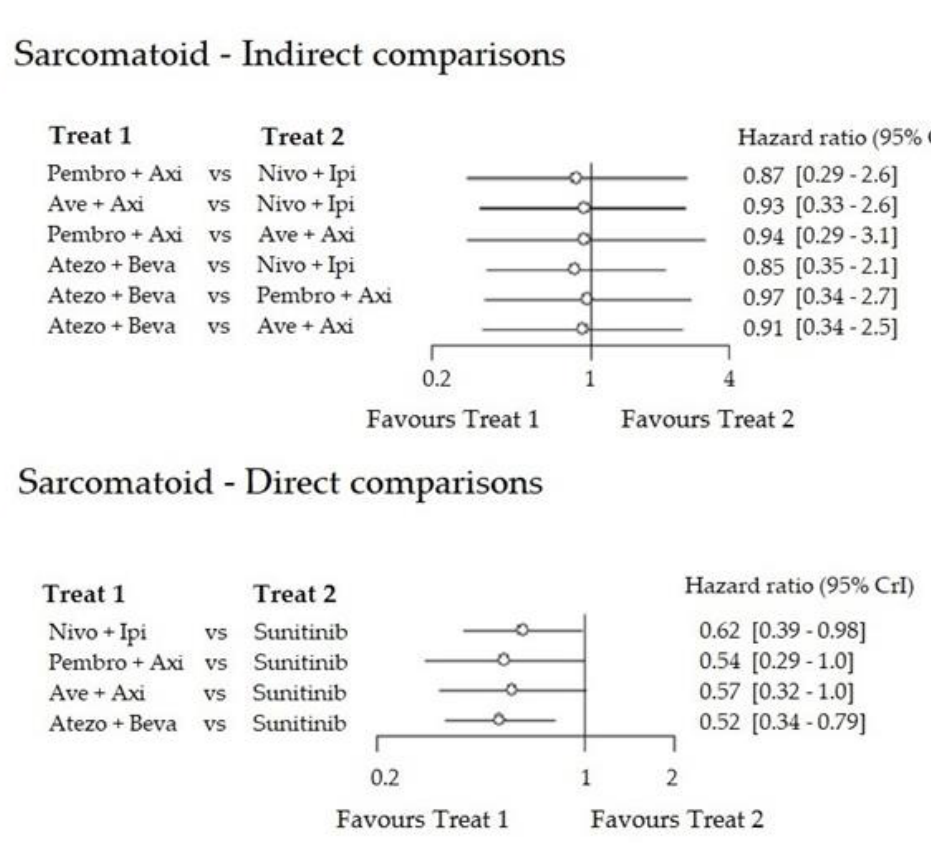
Figure 6. Forest plot of PFS in the sarcomatoid carcinoma population. ( A ) Direct comparisons. ( B ) Indirect comparisons. HRs of treatment in column A versus treatment in column B.